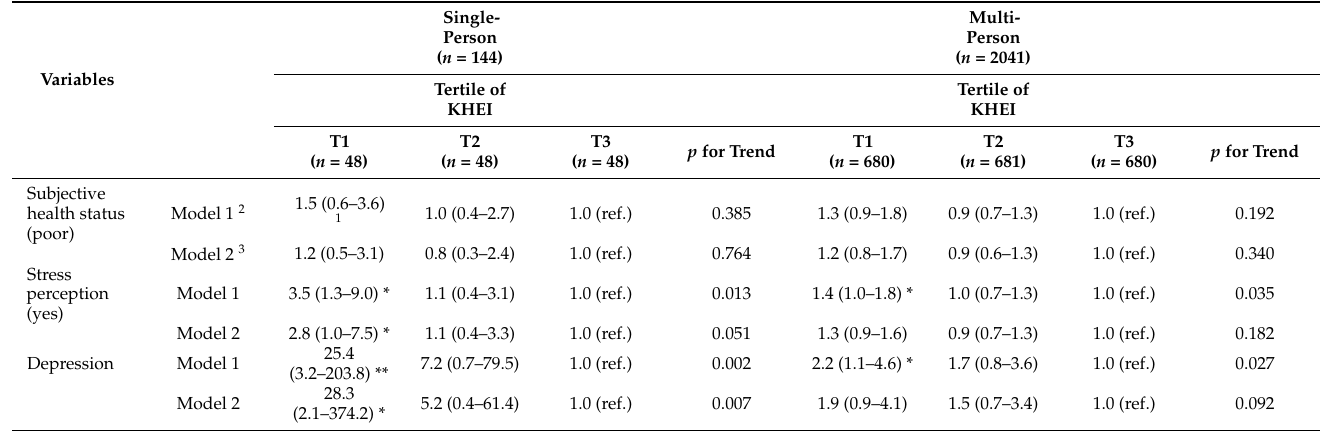
Table 7. ORs for mental health-related outcomes according to KHEI score by household size in